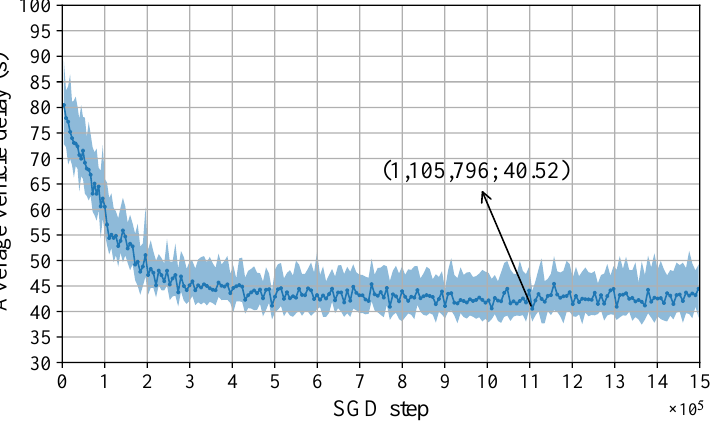
Figure 5. Training curve of the agent. Solid line represents the 50th percentiles of the average vehicle delay across the 50 simulation runs in each test, and shaded area covers the 15–85th